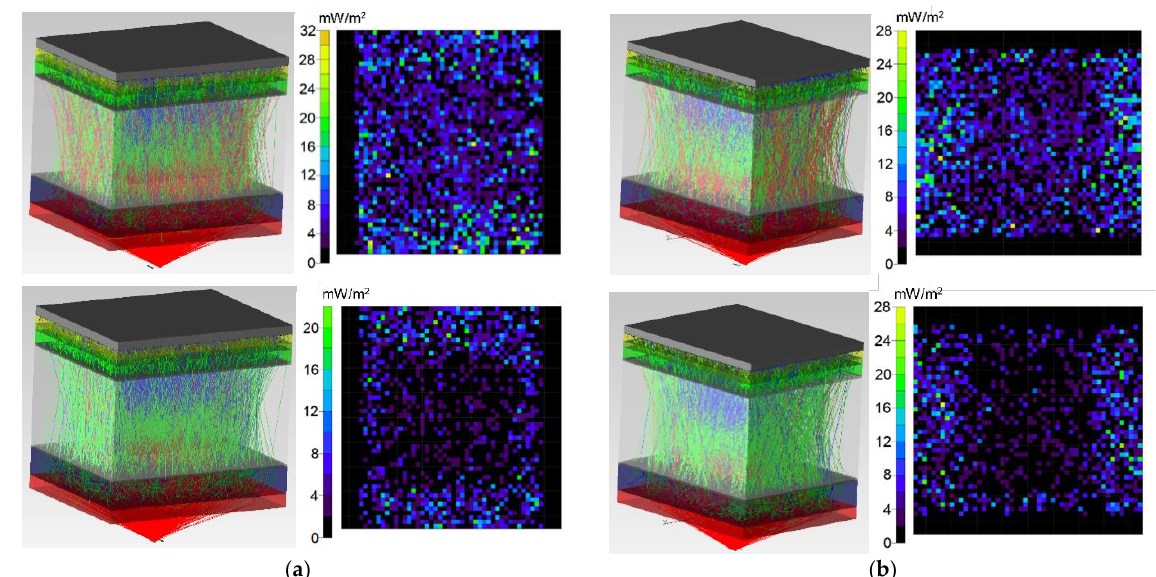
Figure 7. Simulation results for the probe radiation propagation through the maxillary sinus of female ( a ) and male ( b ) with cystic fluid at a wavelength of 650 nm ( top ) and 850 nm ( bottom ).